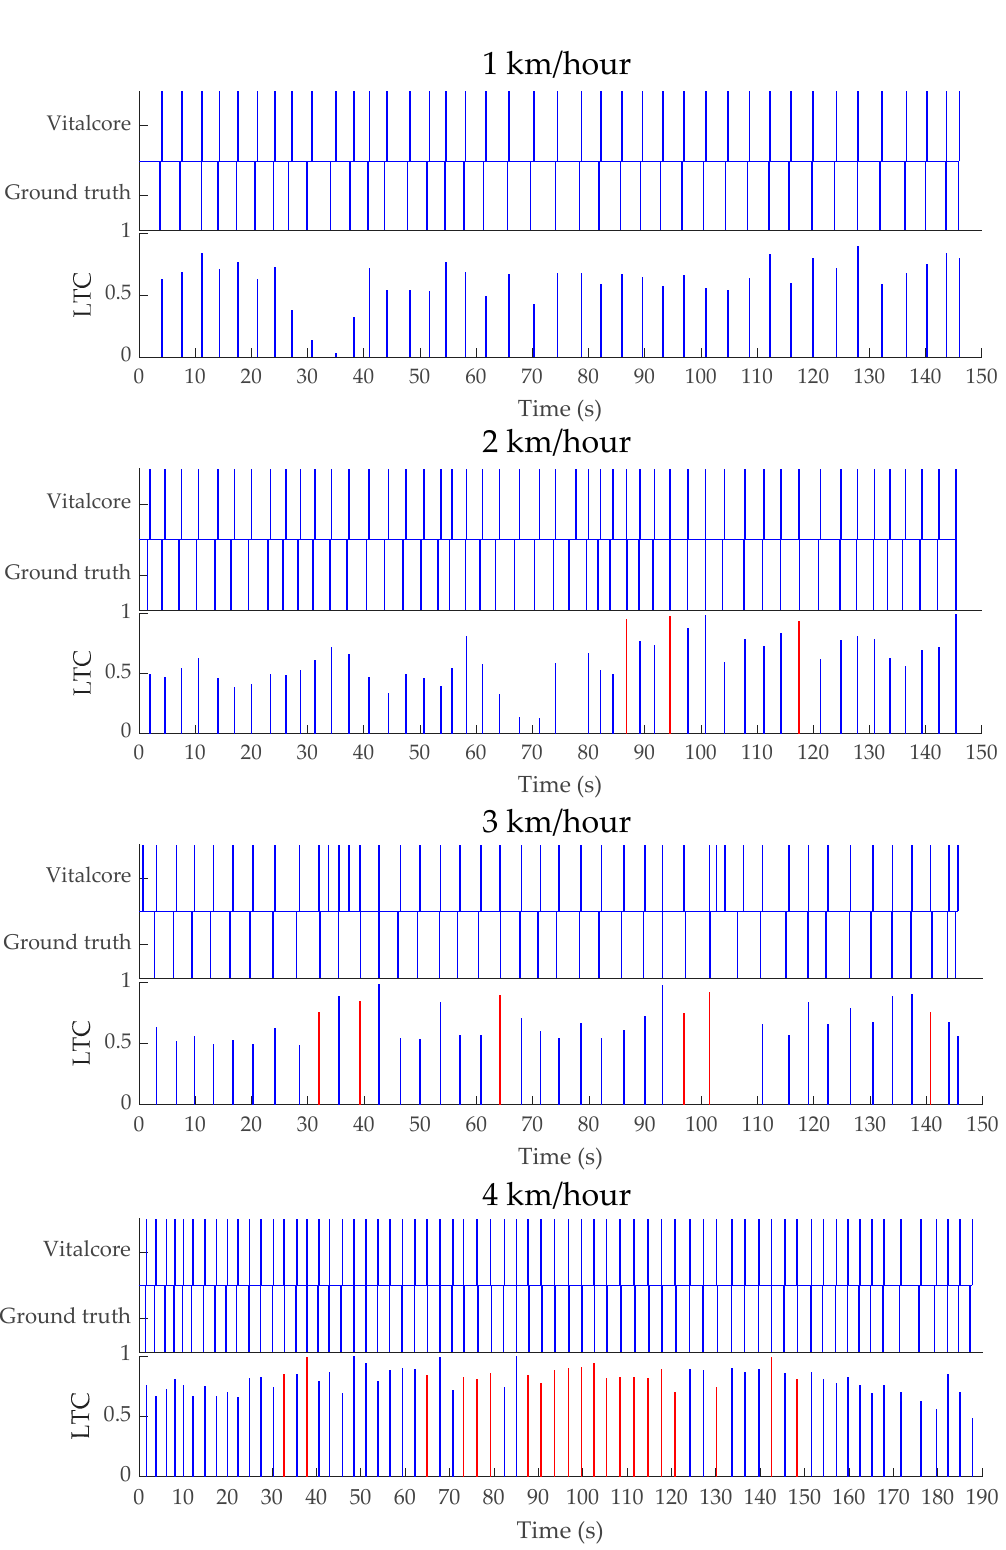
Figure A3. Timestamp graph for ground truth and VitalCore with linear temporal correlation (LTC) between ground truth and VitalCore for walking speeds of 1 km/hour, 2 km/hour, 3 km/hour, and 4 km/hour.